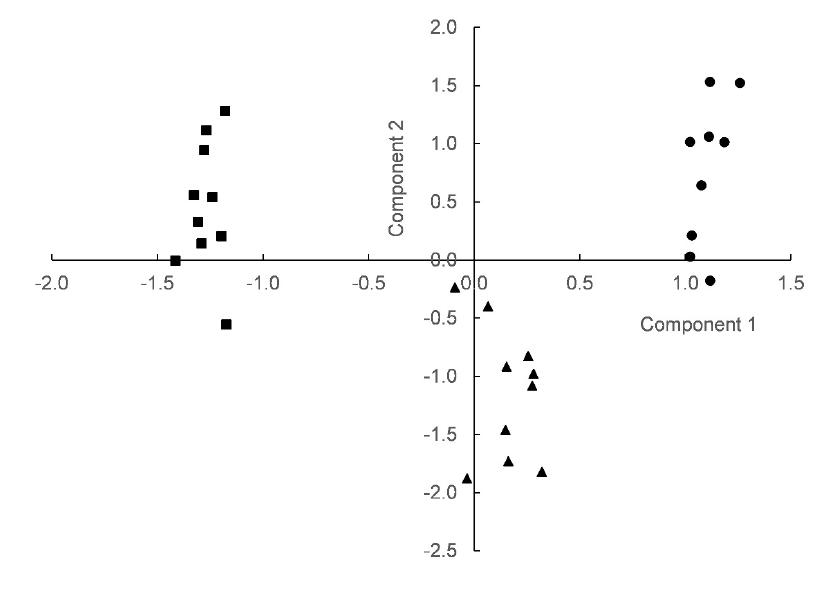
Figure 4. Principal component analysis (PCA) carried out using morphological (LMA and LTD) and physiological ( A , R / A , R , R and A expressed on a mass-base, Chl content, Nmax D Nmax D D Nmax F /F , LCP, LSP, Φ , Φ ) variables for the three phases of leaf development in Corylus. V M PSII max The 1 st component, accounting for 96% of the total variance, was positively related to LSP, A , F /F , Chl content, A on a mass-base, LMA and LTD and negatively to LCP, Nmax V M Nmax R , R / A and R on a mass-base. The 2 nd component explained 3% of the total variance D D Nmax D and it was correlated to Φ . ■ = first phase at developing leaf (IP), ● = second phase at max fully developed leaf (IIP); ▲ = third phase at leaf senescence (IIIP).